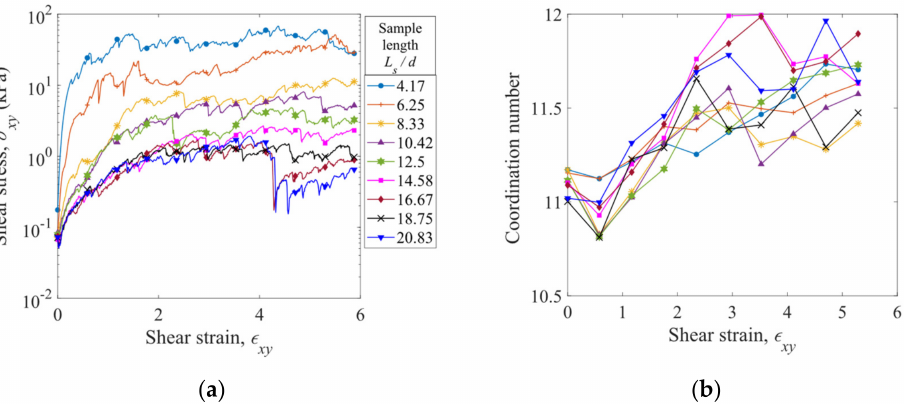
Figure 16. Variations of ( a ) shear stress and ( b ) coordination number with shear strain for the straight fibers with various sample lengths.